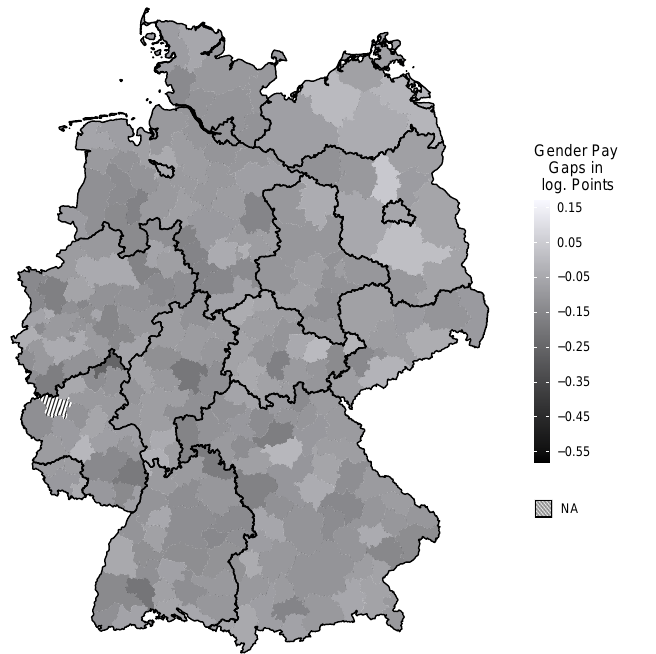
Figure A1. Region Level Adjusted Gender Pay Gaps. Source: SOEPv35; own estimation based on β and random slopes of Model 4 of Table